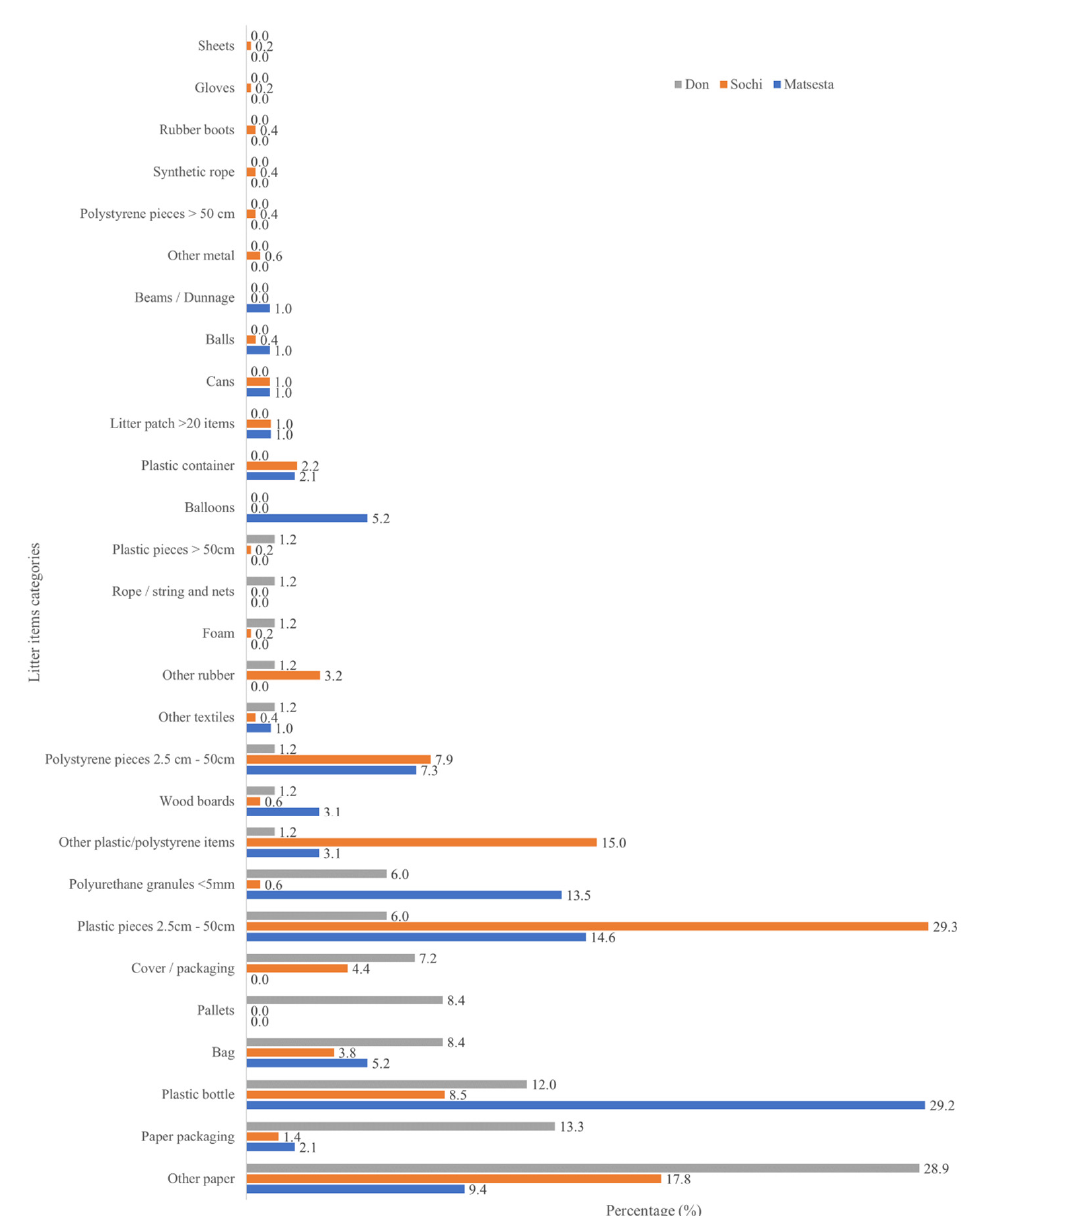
Figure 10. Percentage of recorded litter item categories at the Don, Sochi and Matsesta rivers.